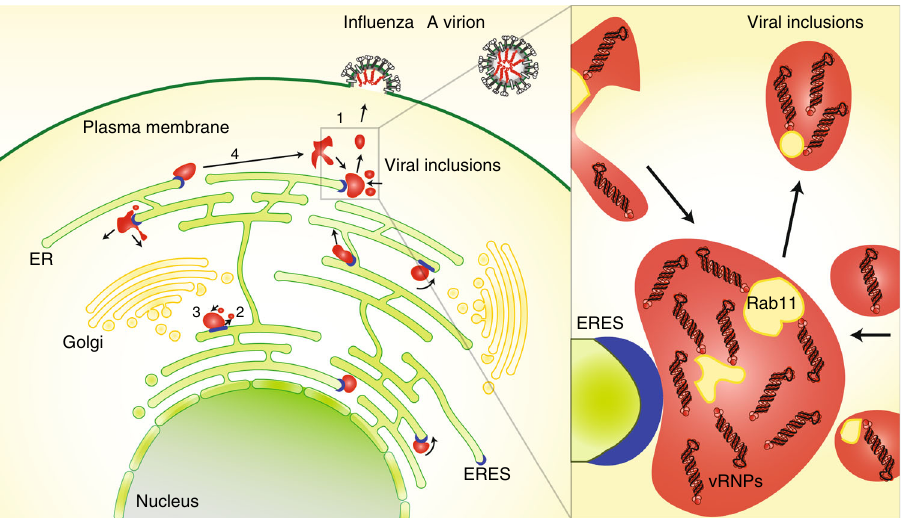
Fig. 10 Proposed model. Viral inclusions (in red) have properties of liquid organelles, segregating from the cytosol without a delimitating membrane. Viral inclusions exchange material dynamically (1) and deform easily, exhibiting fi ssion (2) and fusion (3) events. Viral inclusions can travel long distances before and after fusion/ fi ssion events (4), respectively. These organelles are formed in the vicinity of ERES (in blue) and their assembly is dependent on continuous ER-Golgi vesicular cycling. We propose that viral inclusions trigger nucleation of vRNP – vRNP interactions among the eight different segments to assemble a complete IAV genome. Inlet shows composition of viral inclusions close to ERES. These contain vRNPs of all types, Rab11 and host membranes are clustered, but not delimited by a lipid